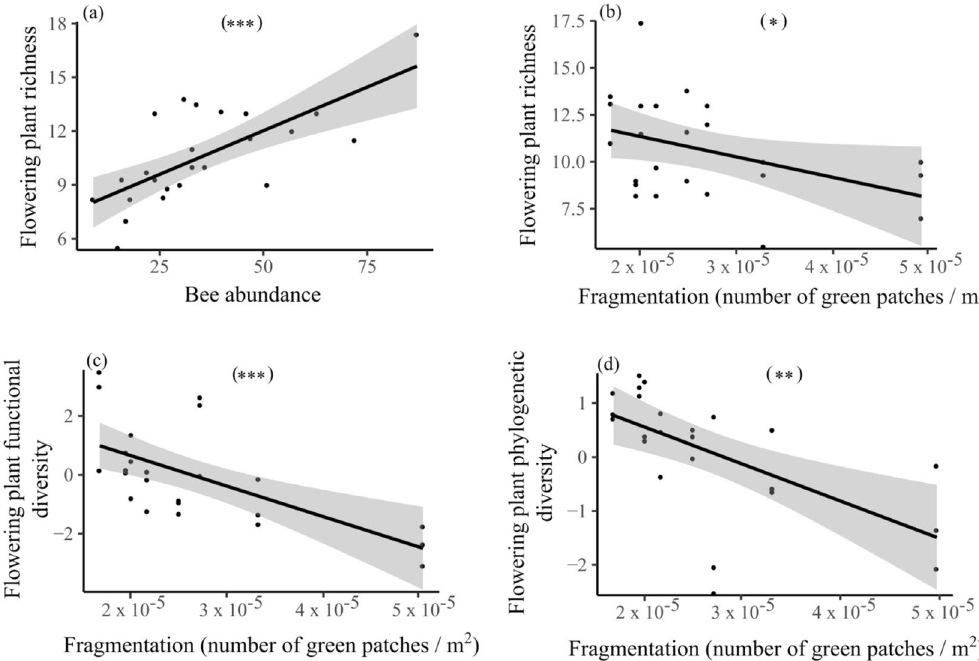
Figure 4. Relationships between ( a ) flowering plant species richness and bee abundance, ( b ) flowering plant species richness and fragmentation (number of disconnected green patches divided by their total surface area), ( c ) flowering plant functional diversity and fragmentation and ( d ) flowering plant phylogenetic diversity and fragmentation. Plotted lines show the predicted relationship and shaded areas indicate the 95% confidence